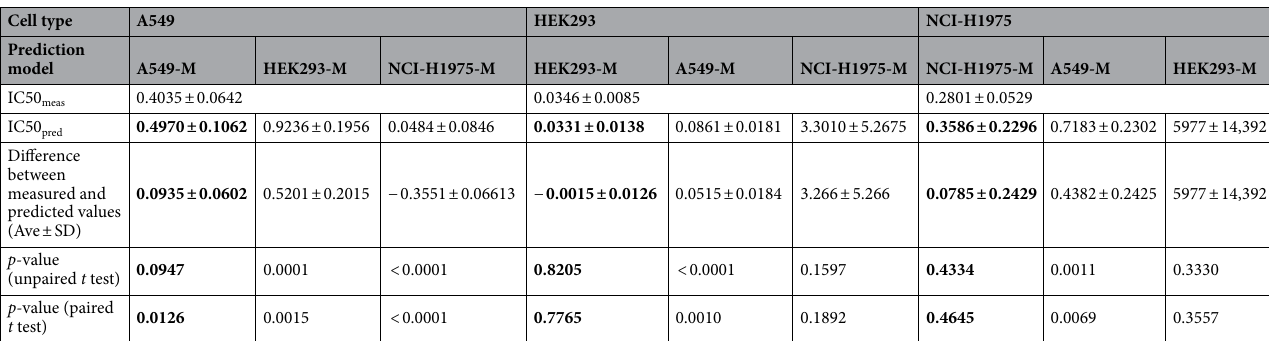
Table 2. Averages and differences between IC50 meas and IC50 pred for doxorubicin effects (n = 6). Prediction values from autologous models are in